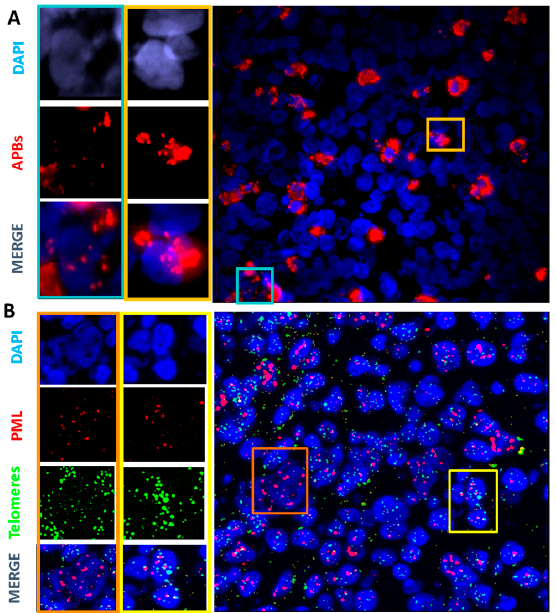
Figure 6. In situ analysis of the presence of APBs in sections of HL lymph nodes. ( A ) Proximity ligation assay (PLA) was used to analyze PML/TRF2 interactions. The yellow frame indicates small cells with multiple and strong signals and blue frame large cells with few signals (40× magnification). ( B ) IF-FISH staining of PML (red) and PNA telomeres (green) show co-localization of PML with telomere sequences in small cells (yellow frame) and high expression of PML in HRS cell with few co-localization signals (orange frame) (40× magnification).